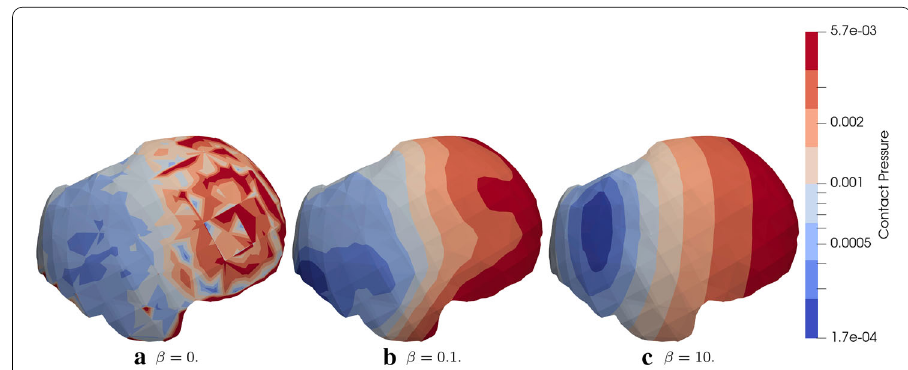
Fig. 14 Impact of penalty parameter β onto the contact